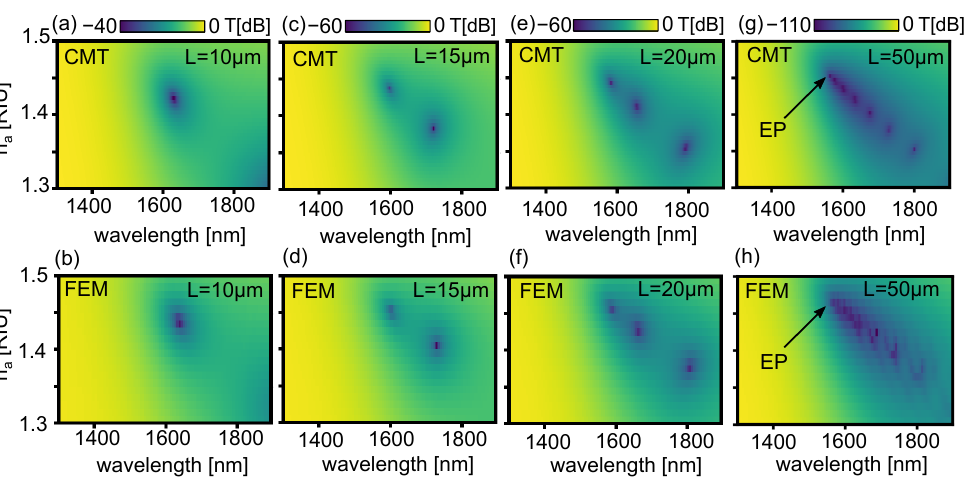
Figure 5. Transmitted power by the plasmonic sensor as a function of λ and n a for L = 10 µ m using ( a ) CMT, and ( b ) FEM. ( c , d ): same as ( a , b ) for L = 15 µ m. ( e , f ): same as ( a , b ) for L = 20 µ